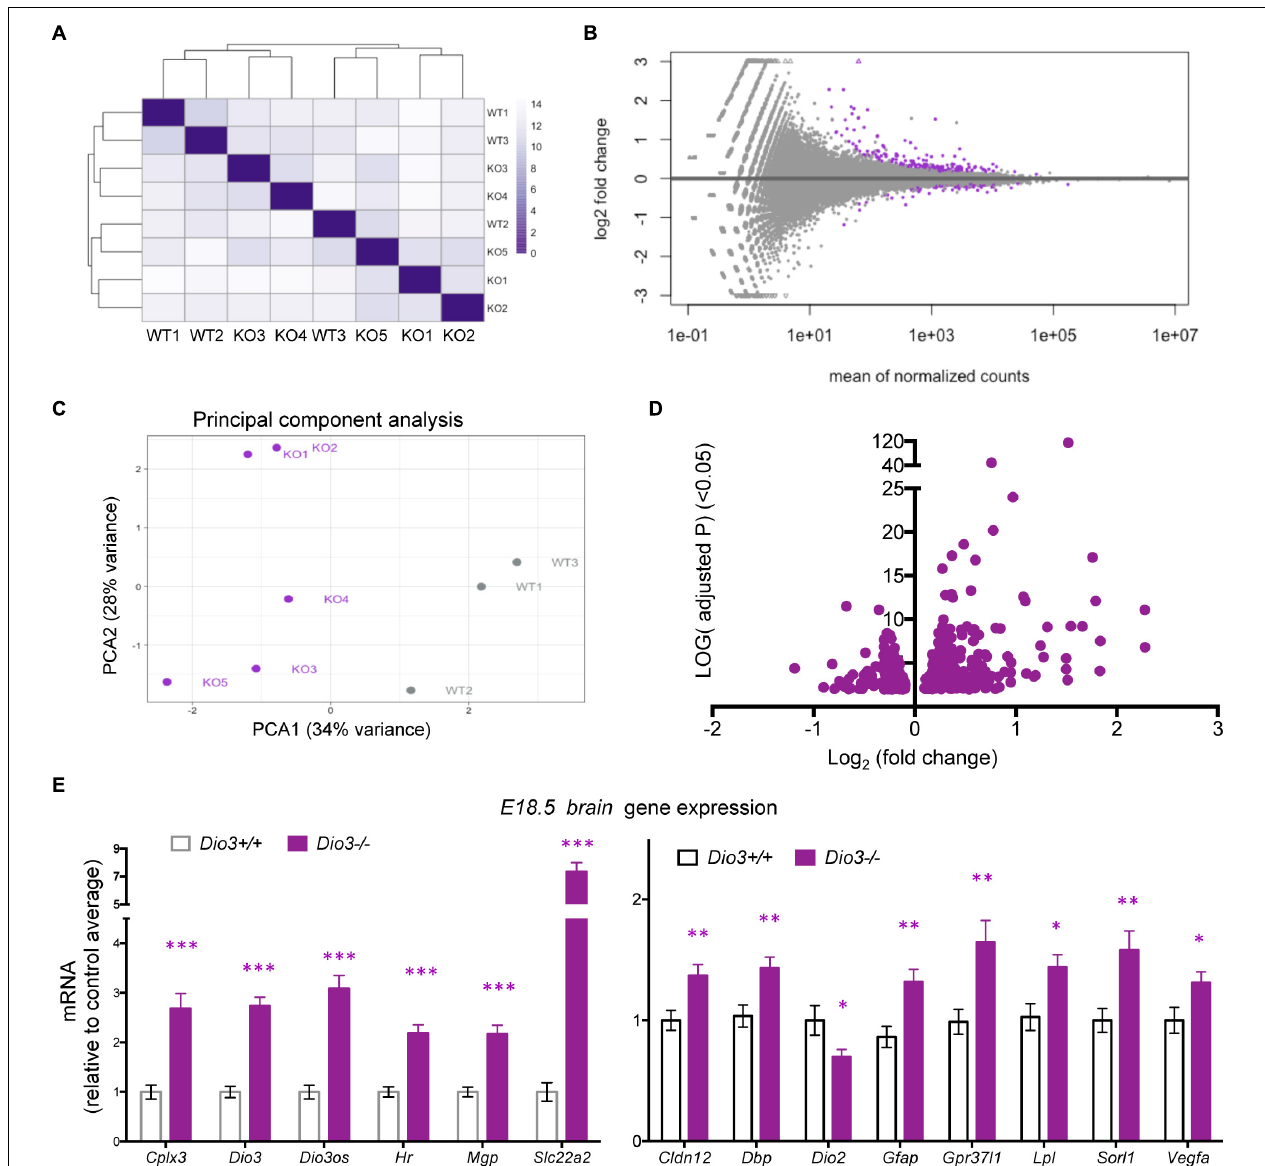
FIGURE 4 | Gene expression profiling of E18.5 Dio3 + / + and Dio3 − / − male brains. (A) heat map representing the expression and clustering of the RNA samples used. (B – D) MA, PCA, and volcano plots showing 588 DEGs (adjusted P < 0.05) in purple color. In PCA panel, WT1-3 and KO1-5 represent samples from Dio3 + / + and Dio3 − / − mice. (E) qPCR validation of selected DEGs in an extended number of samples, including females. Data represent the mean ± SEM relative to control mean value of 11 and 10 different samples from E18.5 Dio3 + / + and Dio3 − / − mice. ∗ , ∗∗ , and ∗∗∗ , indicate p < 0.05, p < 0.01, and p < 0.001, respectively, E13.5 vs E18.5 as determined by the Student’s t -test. (Note: Dio3 − / − mice express Dio3 mRNA, although they carry an inactivation mutation of the coded